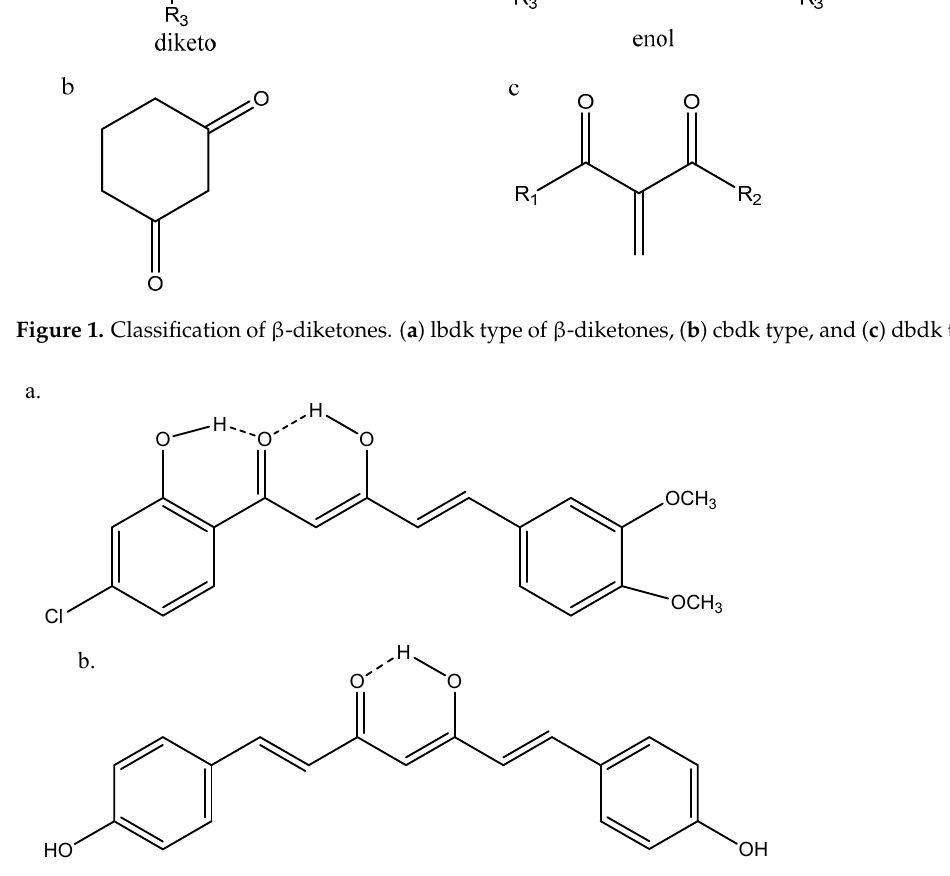
Figure 2. ( a ) (2 Z ,4 E )-1-(4-Chloro-2-hydroxyphenyl)-5-(3,4-dimethoxyphenyl)-3-hydroxypenta-2,4- dien-1-one; ( b ) didesmethoxycurcumin.